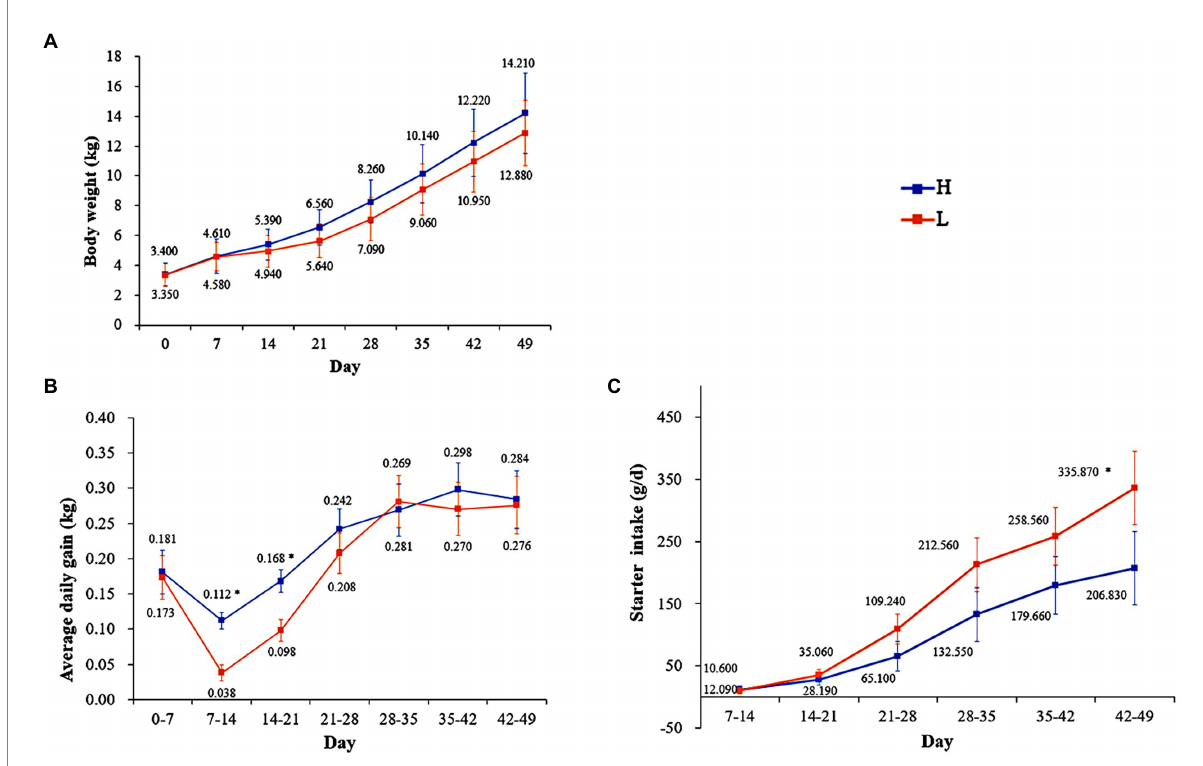
FIGURE 2 Effects of MR levels of on body weight (A) , average daily gain (B) , and starter intake (C) . H: high MR feeding level group, fed MR at 4% DM/kg of average body weight per day; L: low MR feeding level group, fed MR at 2% DM/kg of average body weight/d. * in the same column indicates a significant difference between two groups ( p < 0.05).